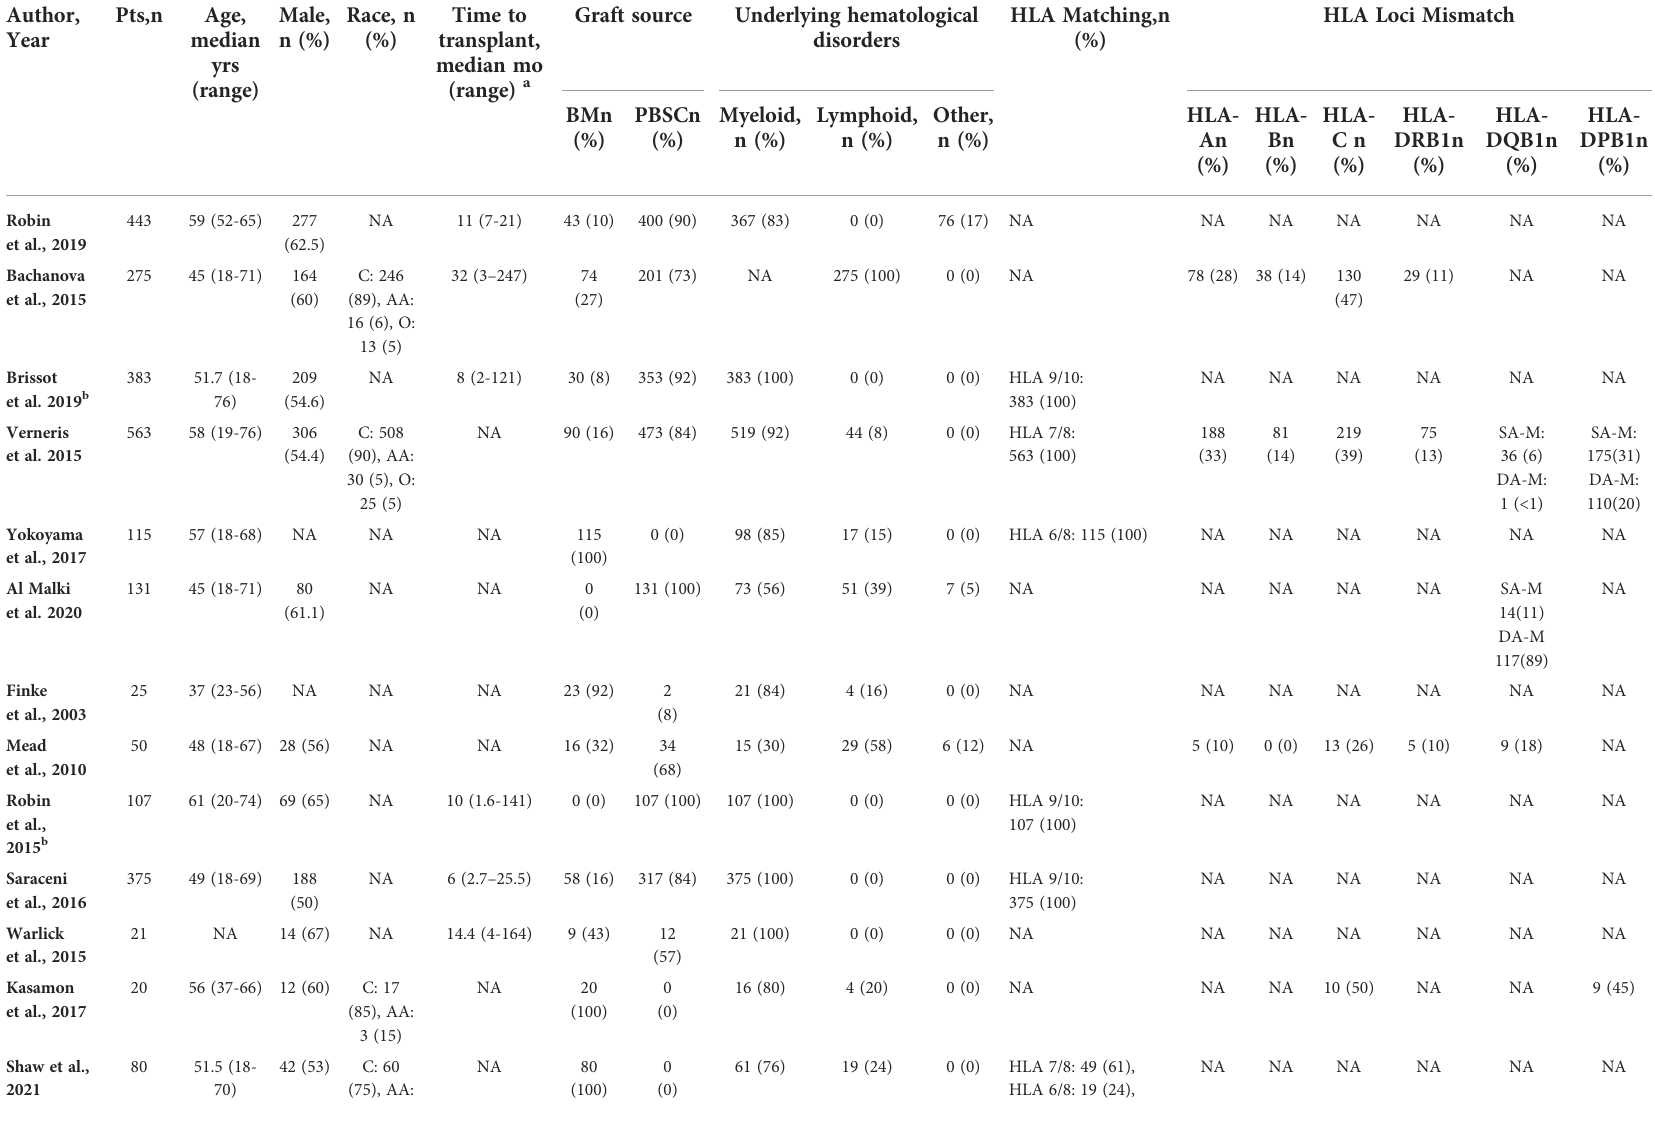
TABLE 1 Baseline characteristics of patients with mismatched unrelated donor allogeneic stem cell